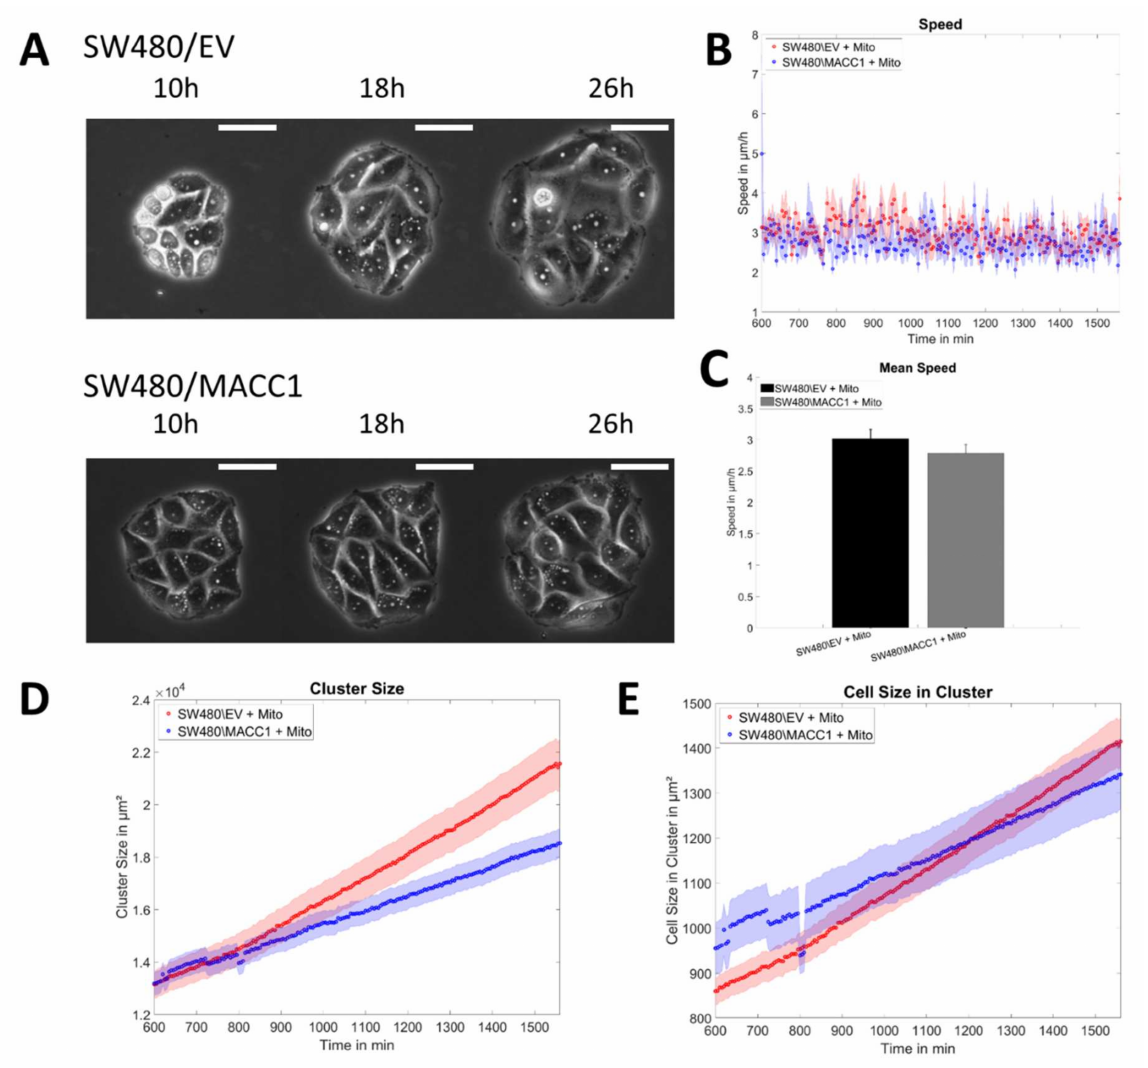
Figure 7. Expansion of small cell clusters without proliferation. ( A ) Illustration of cluster expansion for SW480 cells treated with mitomycin (Mito) during the measurement time, without proliferation. The scale bar depicts 50 µ m. ( B , C ) Speed of cells in clusters of SW480 cells as a function of time or averaged over time. ( D , E ) Total cluster size of SW480 cells over time and normalized to the cell number. Sample sizes: n SW480/EV+Mito = 18; n SW480/MACC1+Mito = 15. Error bars and shaded areas depict the standard error of the